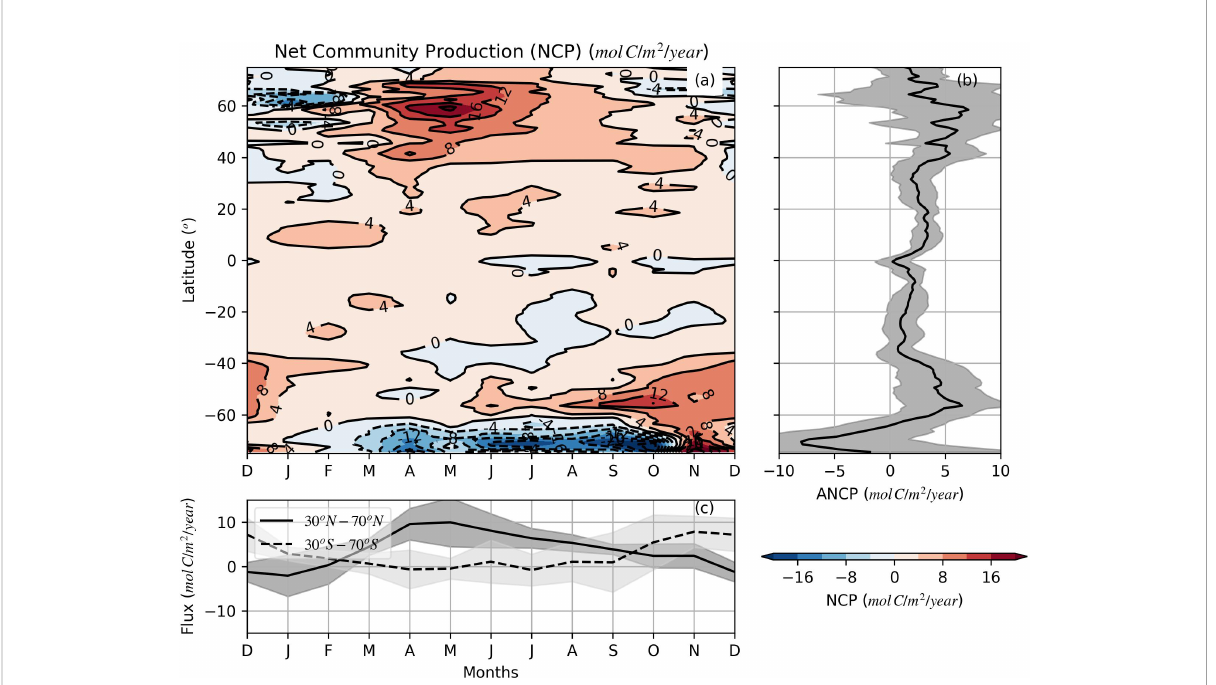
FIGURE 6 (A) Zonally averaged mixed layer net community production (NCP) determined by the O 2 mass balance model. (B) Zonally-averaged annual net community production (ANCP). (C) Monthly time series estimate of NCP between 30° and 70° for both NH and SH. The shadow areas in (B, C) represent the data variability (±1